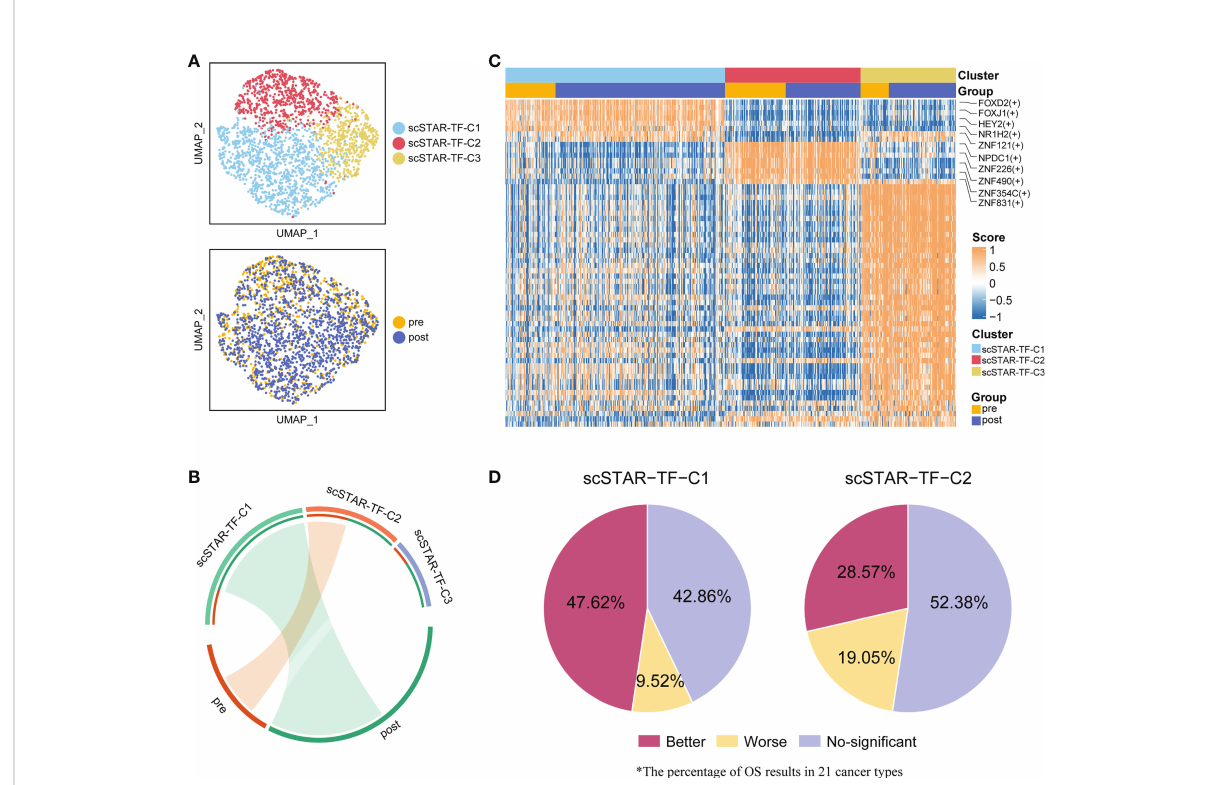
FIGURE 8 scSTAR analysis of gene regulatory networks in CD8 + T cells. (A) UMAP of CD8 + T cells processed by the scSTAR algorithm and SCENIC, colored by sample and cluster. (B) The association between scSTAR-processed clusters and treatment (left) or CD8 + T cell sub-clusters (right). The area of the ties represents the relative enrichment. (C) Heatmap of scaled normalized regulon activity for CD8 + T cells as determined by two-sided Wilcoxon rank-sum test with Bonferroni FDR correction (q < 0.05). (D) The percentage of results predicted by scSTAR-TF-C1 and scSTAR-TF-C2 in 21 cancer